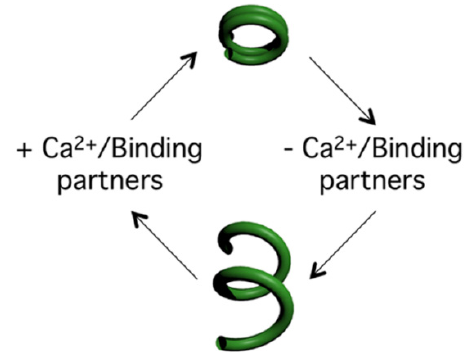
Figure 5. A simplified hypothesis for Tb BILBO1 polymer formation. Our current working hypothesis is that Tb BILBO1 has intrinsic polymer forming properties and these can be influenced to form annular or helical structures based on the tight binding of one or two calcium ions as well as parasite specific proteins. The balance between protein and calcium binding in turn will fluctuate based on the life cycle and cell cycle stage of the parasite.